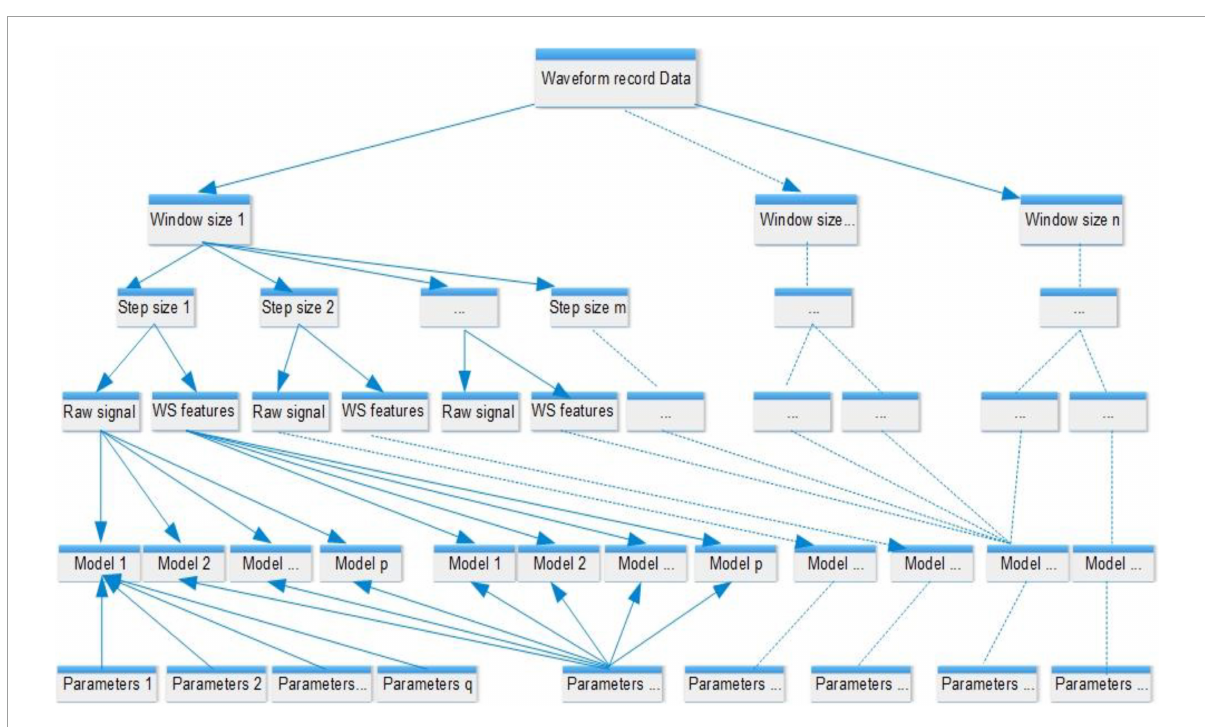
FIGURE1 Comparison design. Each model is configured by a set of learning parameters and supplied features, either raw signal or wavelet scattering features that were generated from waveform records with different window sizes and step lengths. The analyzed values of the window size ranged from 0.5 to 5 s, and the step sizes ranged from 0.1 s to the value of the window size. An example of the segmentation of waveform records is shown in Figure 2B . A total of 11 models were compared, including generalized linear regression, ridge regression, lasso